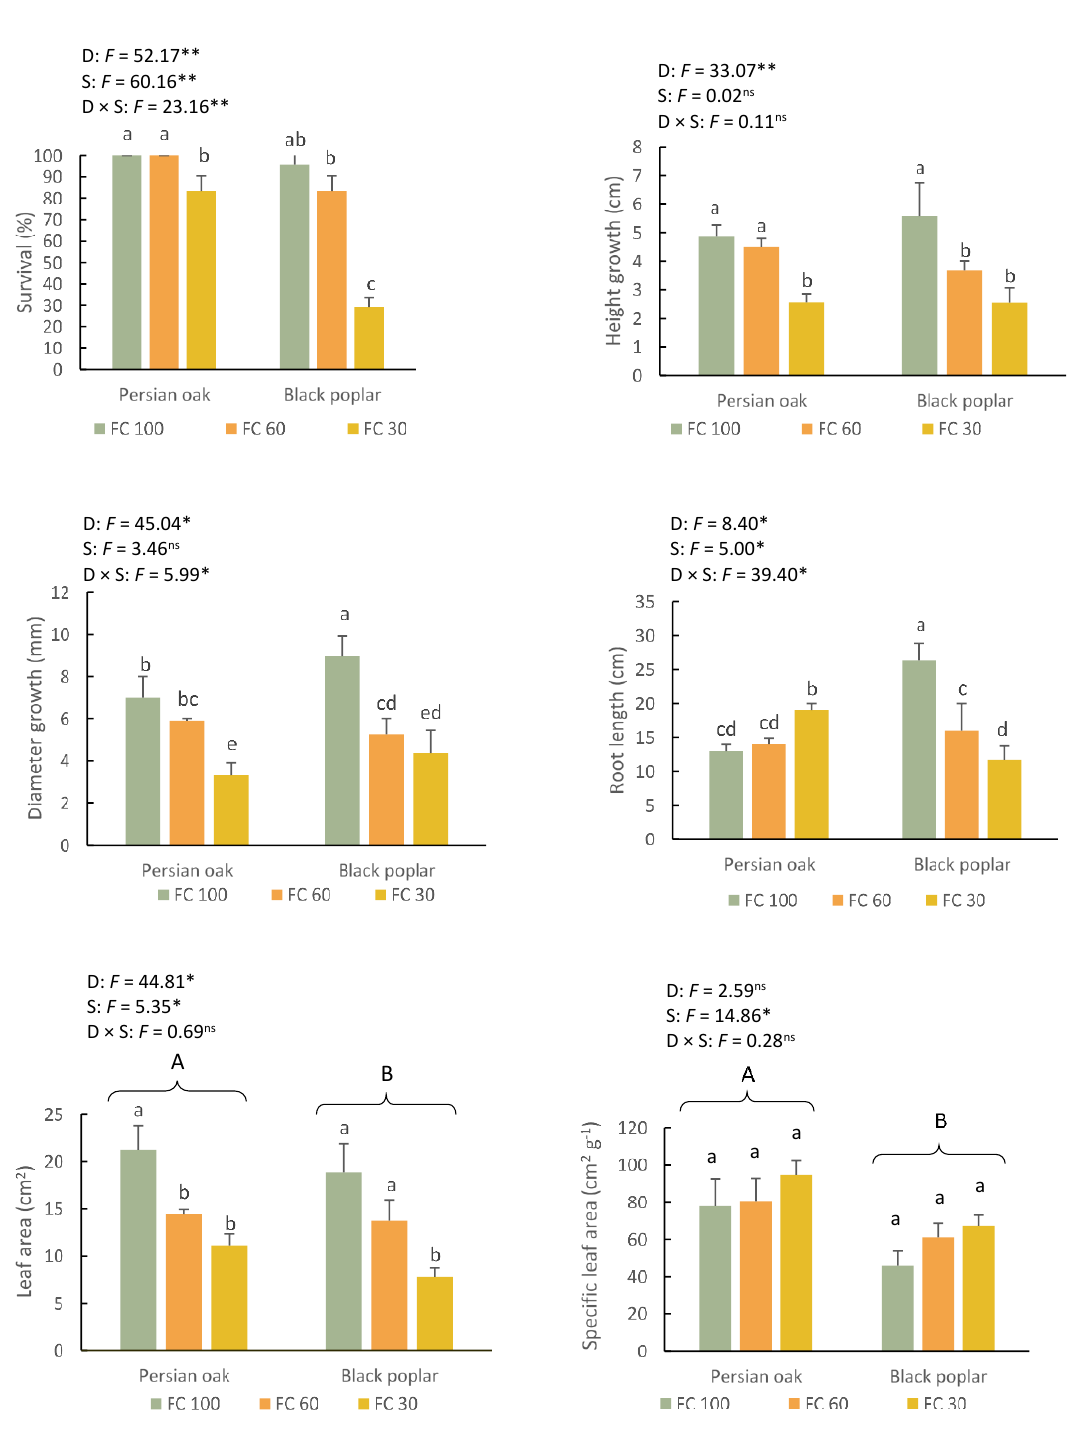
Figure 2. Survival, height and diameter growth, root length, total leaf area, and specific leaf area of Persian oak and black poplar seedlings as a function of soil water deficit. Means ± standard deviation, n = 3 blocks. Different lower-case letters indicate statistically significant differences based on Duncan’s multiple range post-hoc test ( α = 0.05). In the presence of a significant interaction between drought (D) and species (S), the significance letters are valid across species but only remain valid within species when the interaction (D × S) was not significant. Different upper-case letters indicate statistically significant differences between species in the absence of a significant D × S interaction. * p < 0.05, ** p <